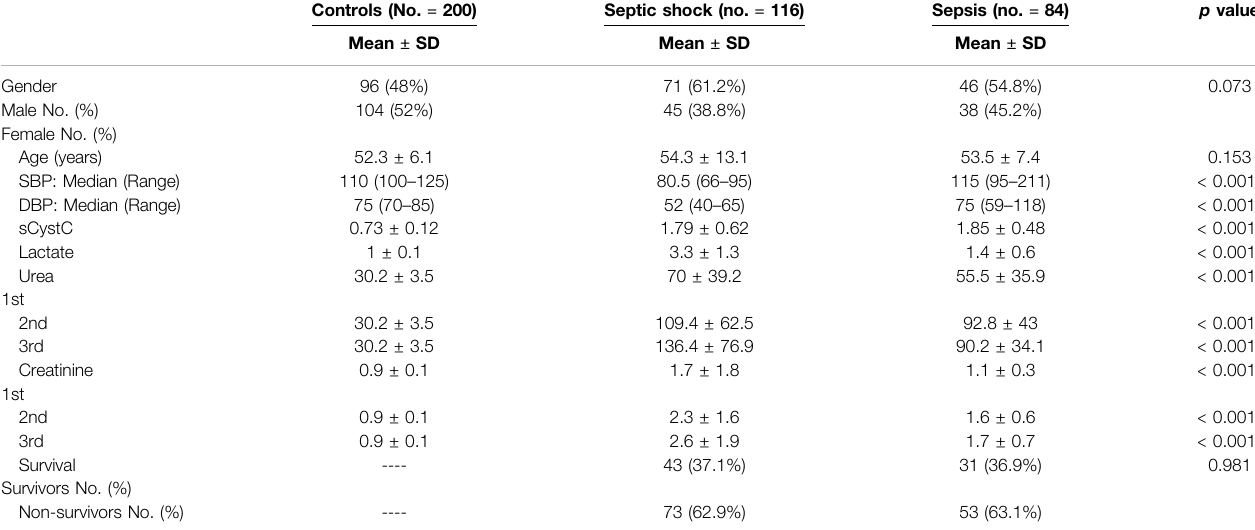
TABLE 1 | Demographic and clinical characteristics of studied groups. Controls (No. = 200)